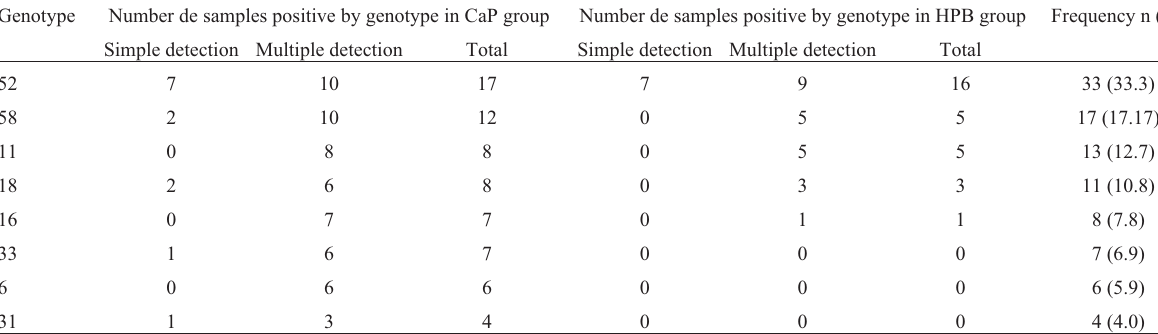
Table 2 - Frequency of HPV genotypes detected from study samples.